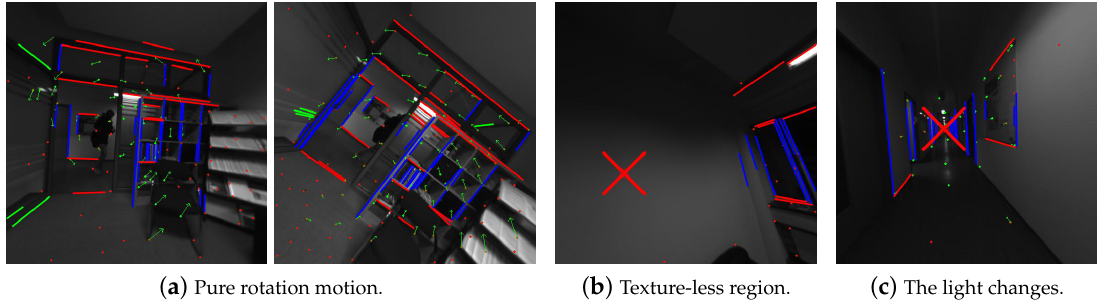
Figure 8. In the scenes of texture-less region, light change, and pure rotation motion, pose estimation method based on point features are easily affected. In contrast, structural features provide scene structure information, an excellent supplement to the point-features based approach.